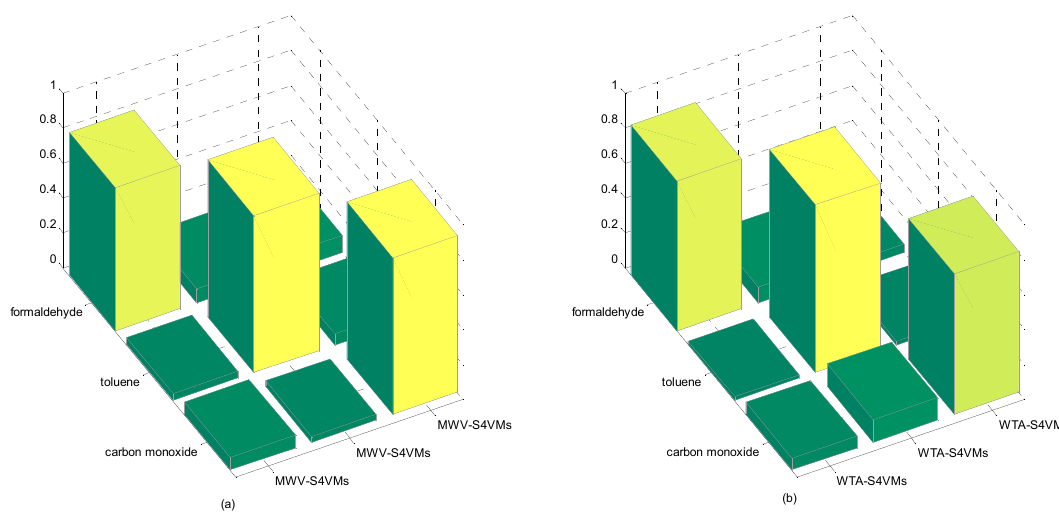
Figure 1. Total accuracy of the two multi-classification methods.